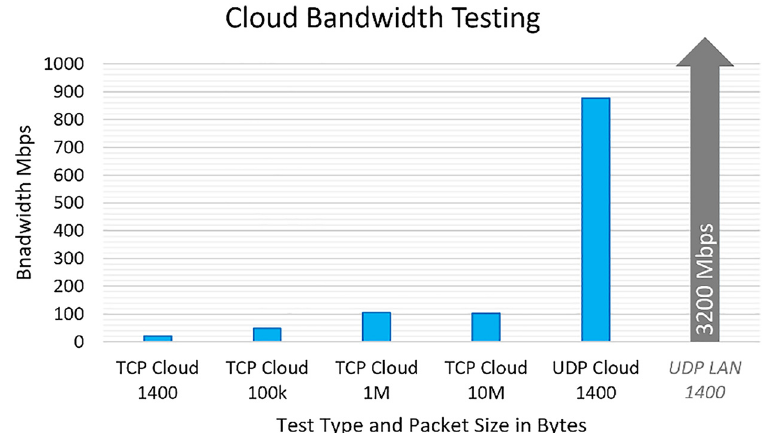
Figure 5: Comparison of TCP and UDP network performance. The